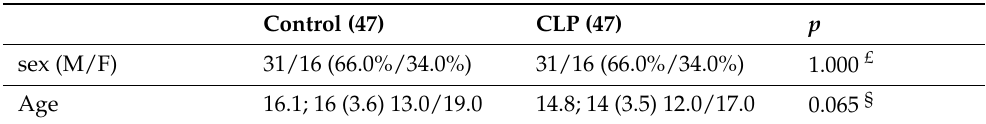
Table 2. Control and CLP group for sex and age. Control